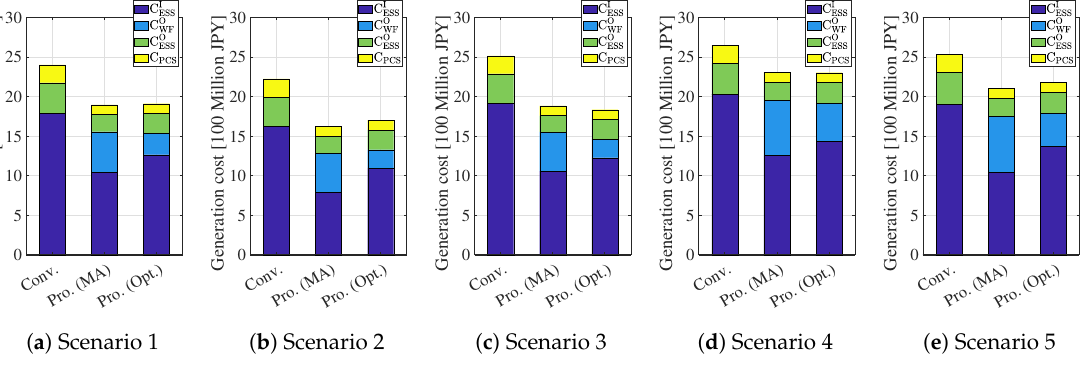
Figure 16. Cost (Li-ion battery).